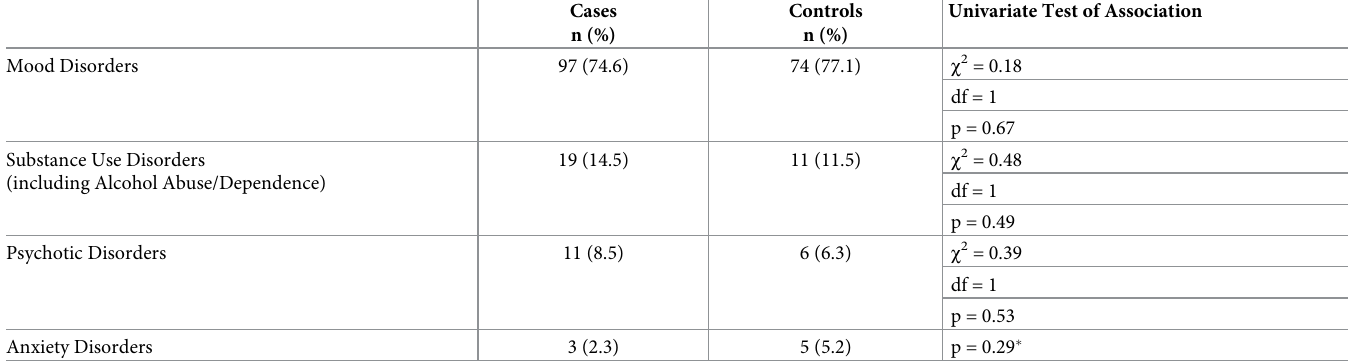
Table 2. Primary diagnosis of psychiatric disorders (DSM-IV Axis I diagnosis).